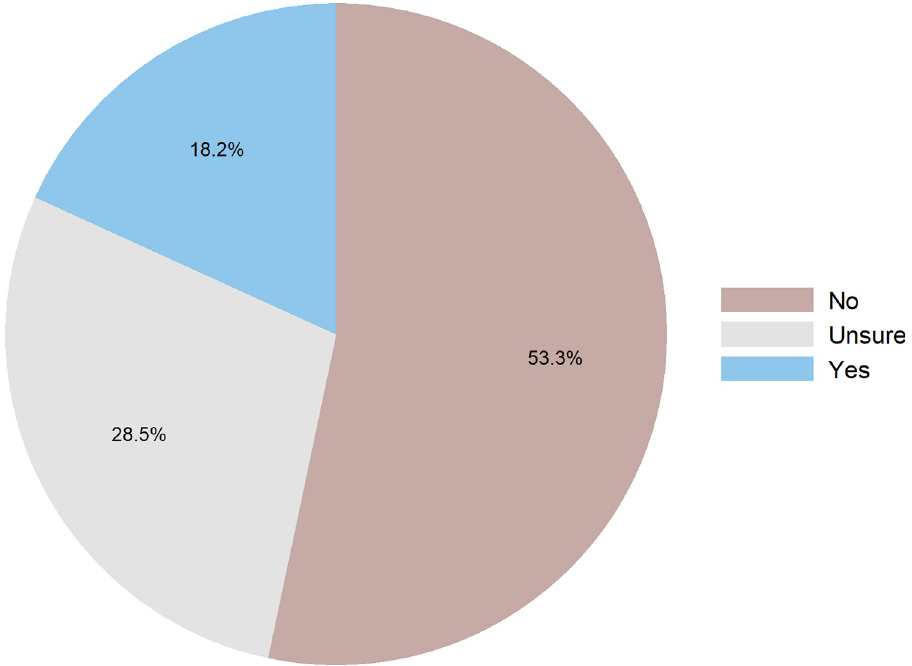
Fig 1. Levels of vaccine hesitancy in PNG from phone